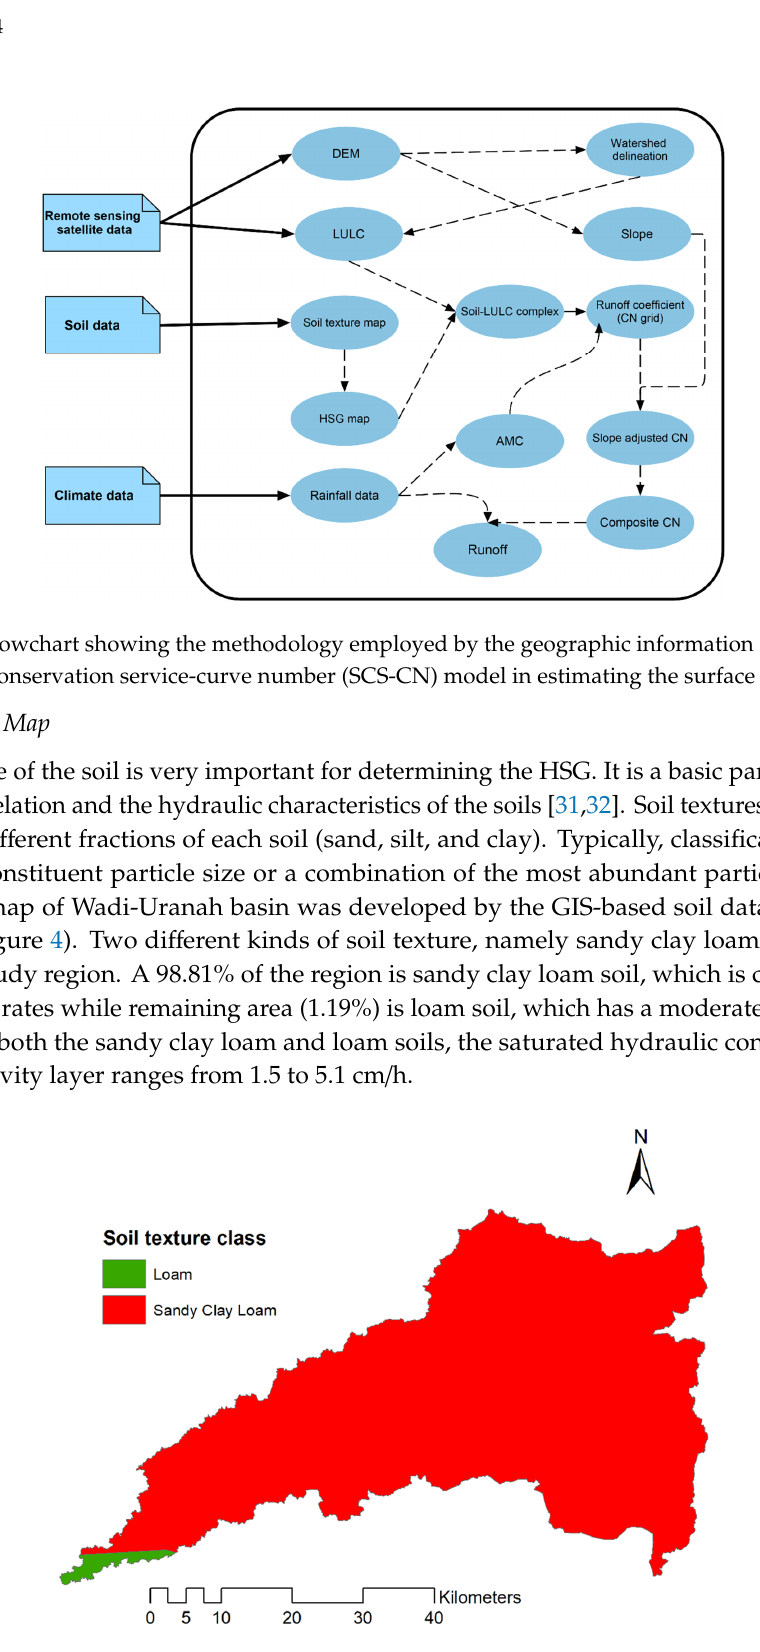
Figure 4. Soil textural class map of the study area.